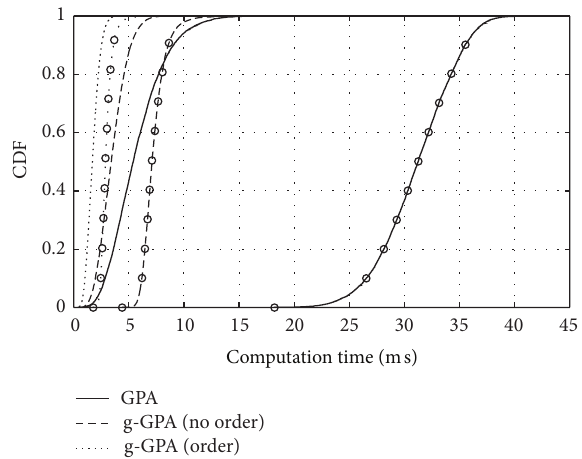
Figure9:Cumulativedistributionfunctionofthecomputationtime for a 1024-subcarrier system and P target 𝑏 = 10 −3 at SNR values of 15dB (without circles) and 35 dB (with